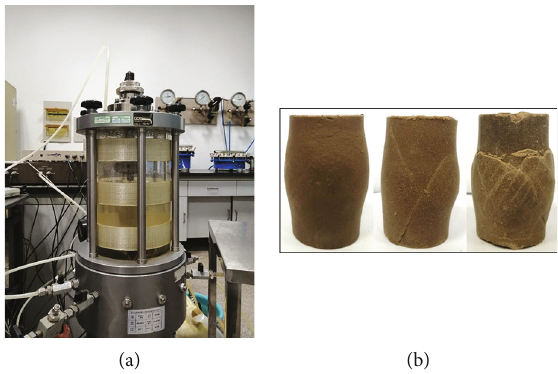
Figure 4: Testing system and soil sample: (a) the GDS triaxial test apparatus; (b) the samples after test [19].